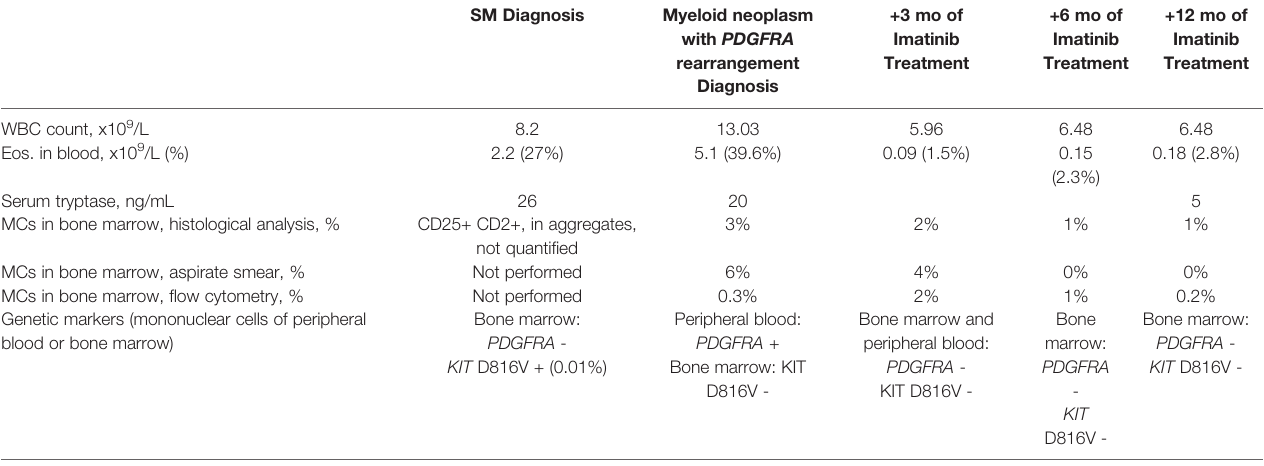
TABLE 1 | Relevant blood and bone marrow parameters in the main time-points from diagnosis of systemic mastocytosis. SM